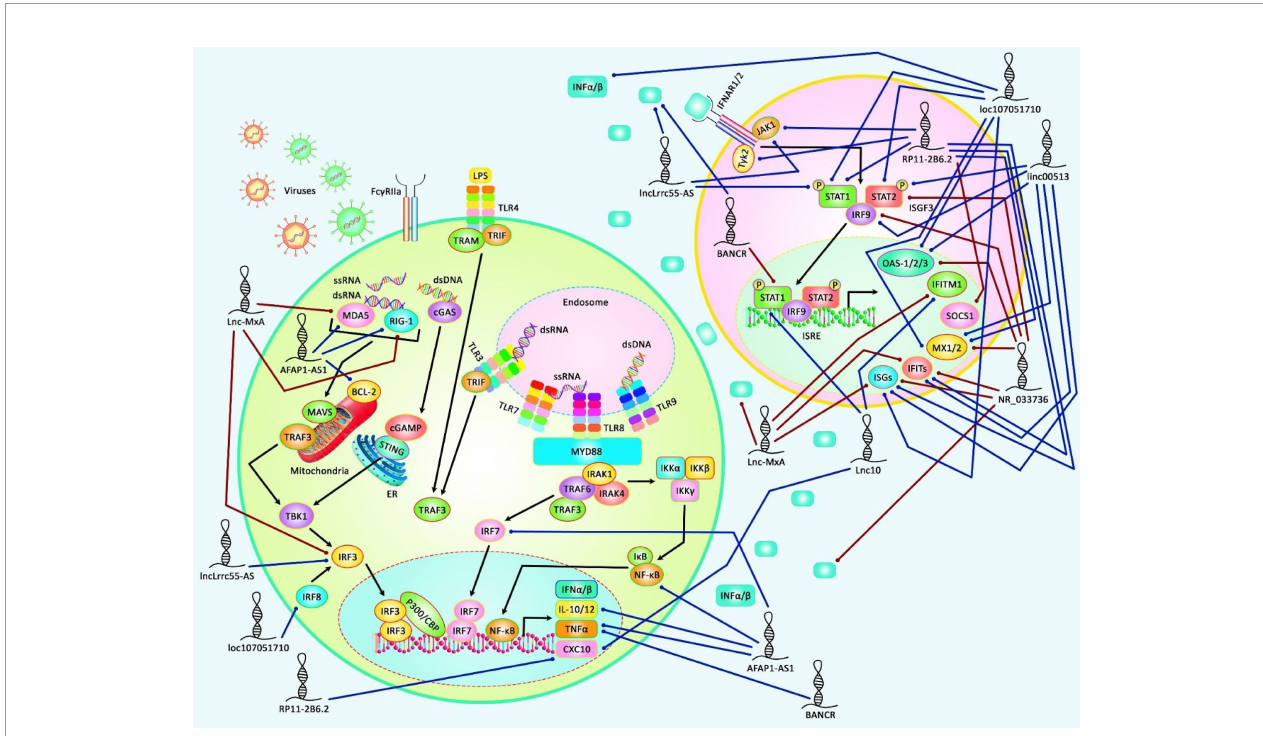
FIGURE 2 | A schematic illustration of the role of several lncRNAs in regulating the IFN signaling pathway in several human diseases, including autoimmune conditions and viral infections. Accumulating evidence has illustrated that lncRNAs modulating IFN signaling cascade could participate in the pathogenesis of various kinds of human cancers as well as immune-related disorders. It has been reported that lncRNA RP11-2B6.2 could play an important role as a positive regulator of type I INF signaling pathway in Lupus Nephritis via up-regulating the expression levels of IFIT-1/3, ISG, Mx2, CXCL10, JAK1, STAT-1, TYK2, and decreasing SOCS1 expression (69). Moreover, another research has revealed that lncRNA loc107051710 could elevate the expression levels of IFN- a , IFN- b , Mx1, STAT-1/2, OAS via modulating IRF8, thereby enhancing the antiviral activity of ISGs to prevent infectious bursal disease virus (IBDV) infection (73). Blue lines indicate the positive regulatory effect among lncRNAs and their targets, and brown lines depict a negative one among them. All the information regarding the role of these lncRNAs involved in the modulation of the IFN signaling cascade in various types of immune de fi ciency diseases and cancers can be seen in Table 3